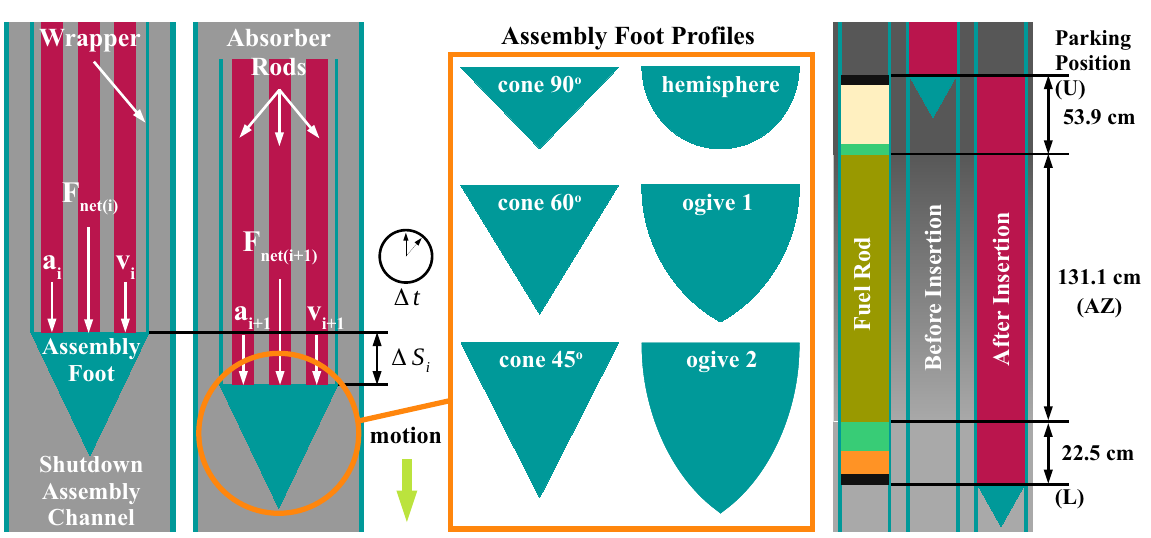
Figure 2: Representative Images of the Assembly Insertion Model, Idealised 2D Sections of the Assembly Foot and the Different Regions Considered in the Channel Skin-friction coefficient was computed considering mixed laminar-turbulent flow over a flat